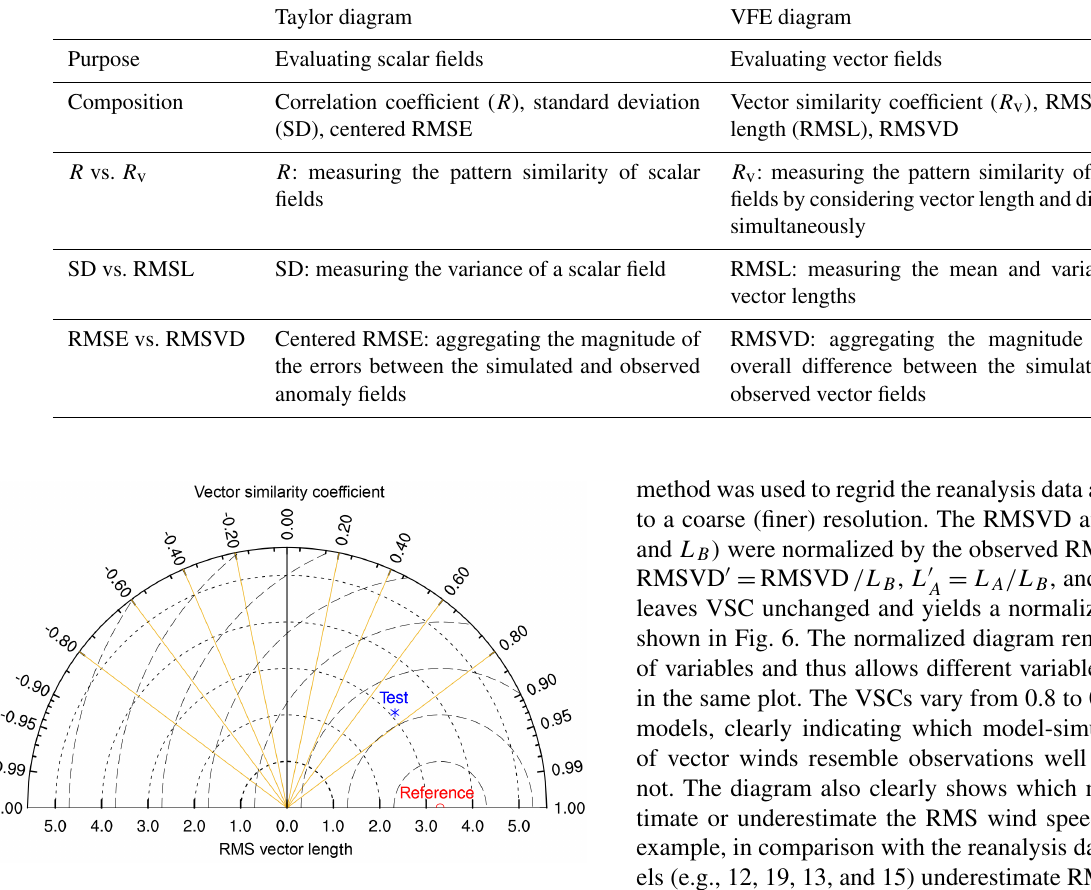
Figure 5. Diagram for displaying pattern statistics. The vector sim- ilarity coefficient between vector fields is given by the azimuthal position of the test field. The radial distance from the origin is pro- portional to the RMS length. The RMSVD between the test and ref- erence field is proportional to their distance apart (dashed contours in the same units as the RMS